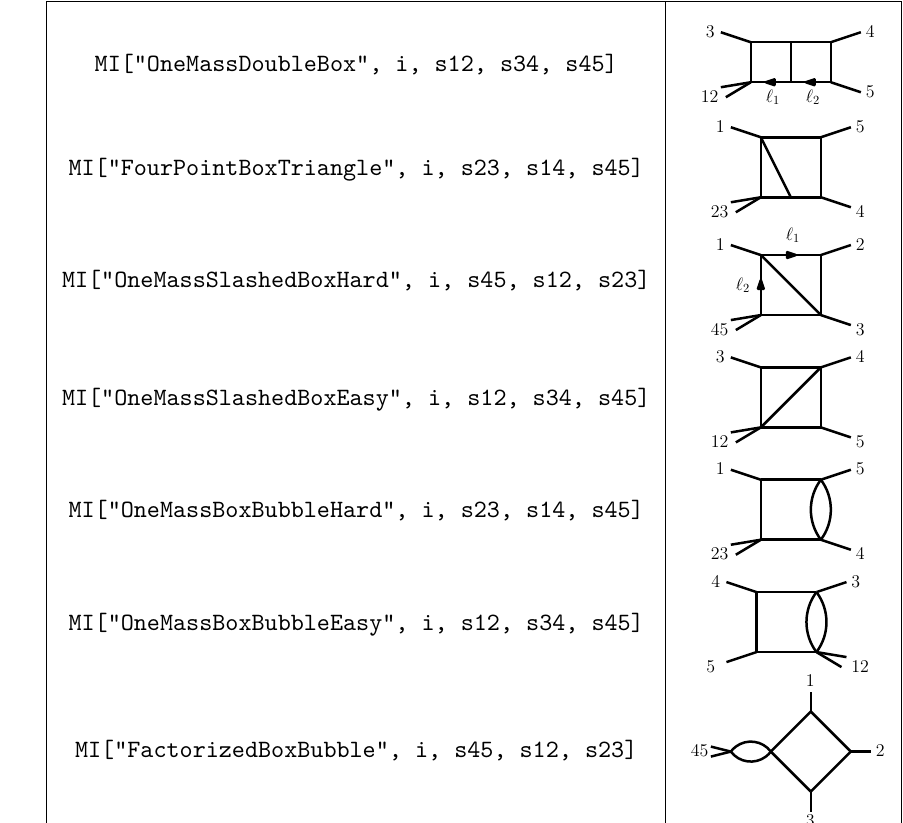
Table 10. Permutation representatives for four-point two-loop master integral